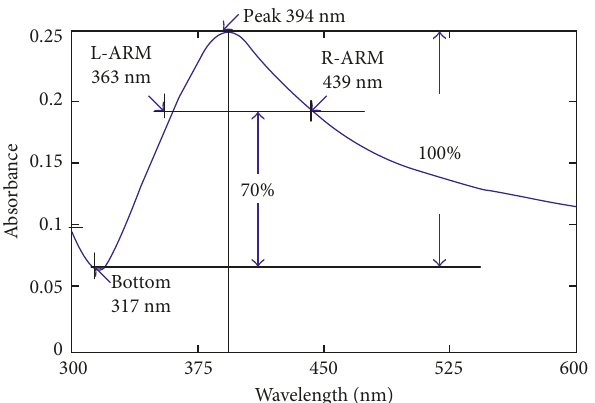
Figure 11: UV-Vis ( arcing in DW + PVA for 12 min, band width = 76 nm, 96 nm, at absorbance 70% height). (cid:31)